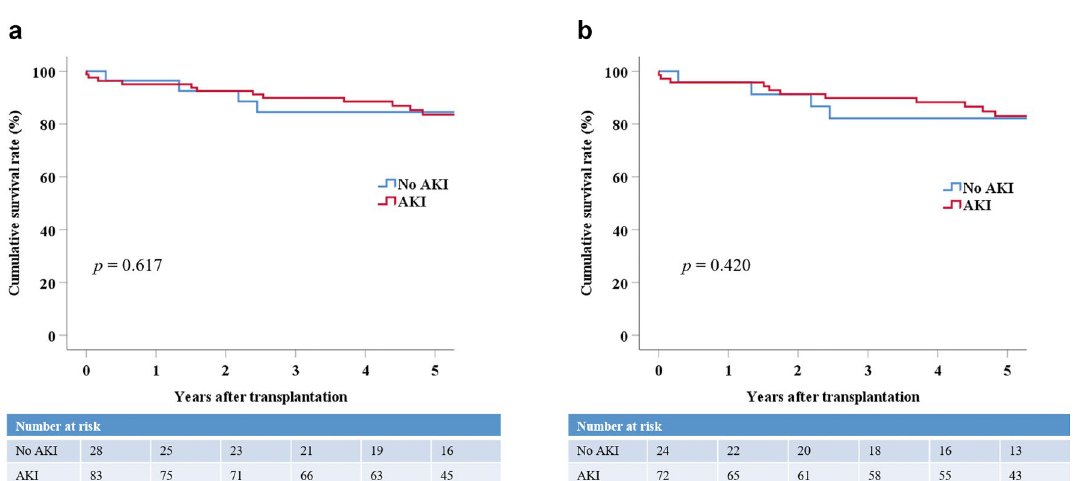
Figure 3. Death-censored graft survival in recipients receiving kidneys from ECD and high KDPI (≥ 80) donors stratified by the presence of AKI. ( a ) Death-censored graft survival in recipients receiving kidneys from ECDs stratified by the presence of AKI. Group comparisons were performed using the Kaplan–Meier and log-rank tests. ( b ) Death-censored graft survival in recipients receiving kidneys from high KDPI (≥ 80) donors stratified by the presence of AKI. Group comparisons were performed using the Kaplan–Meier and log-rank tests. ECD expanded criteria donor, KDPI kidney donor profile